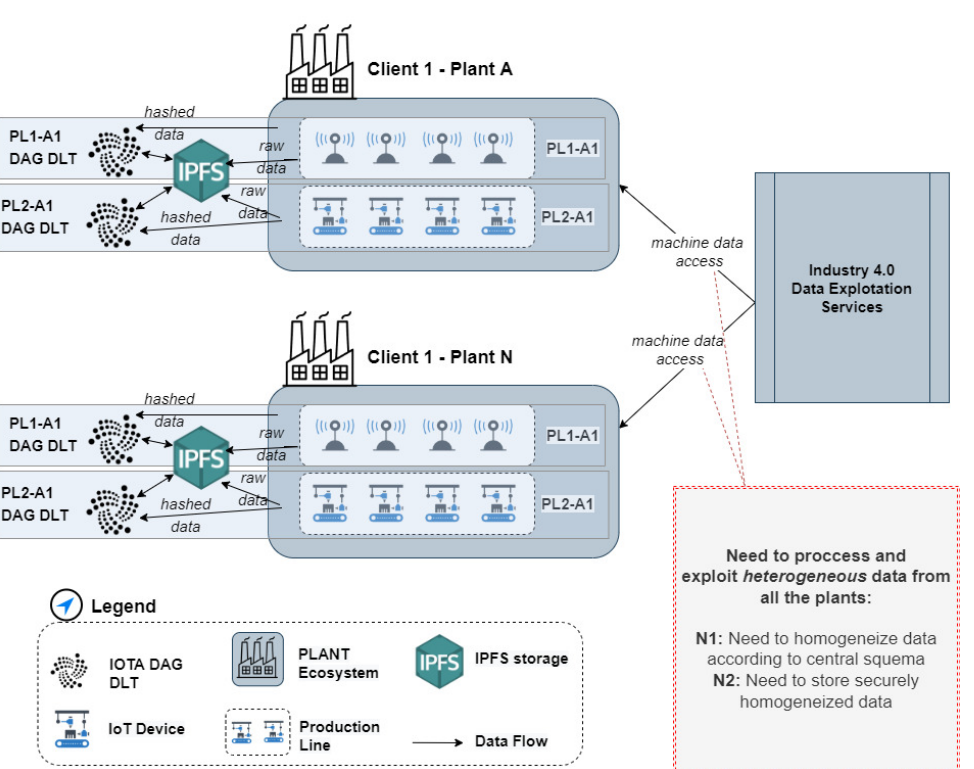
Figure 1. Industry 4.0 motivating